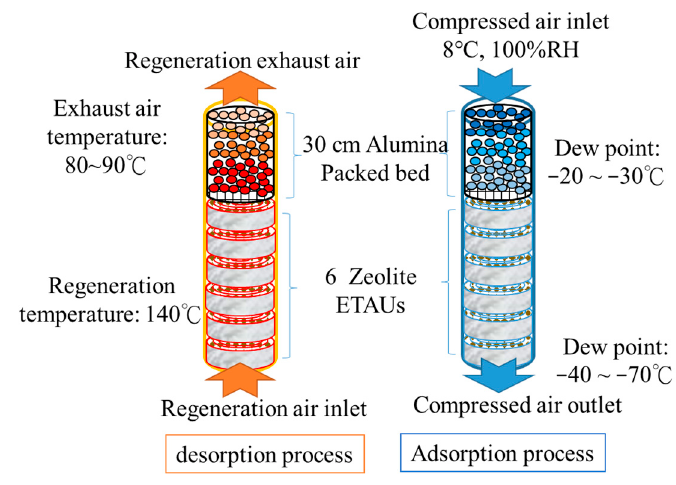
Figure 4. Operation principle of the composite system.